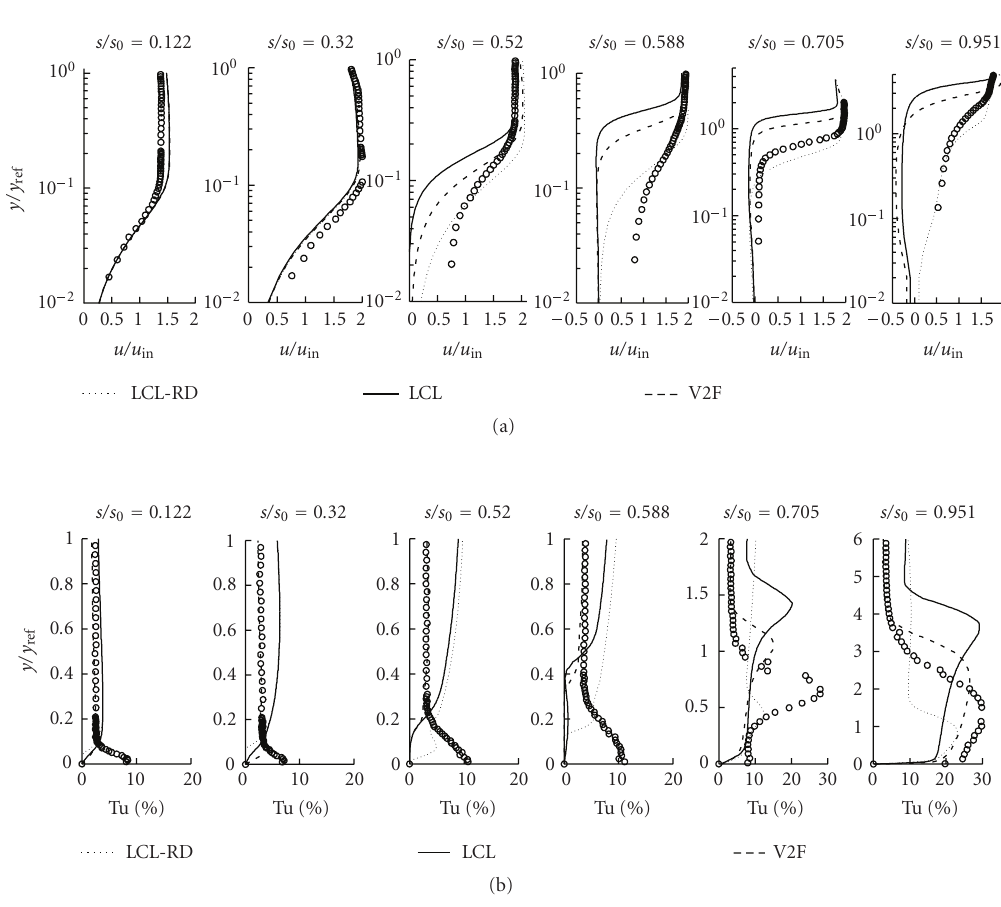
profile in and downstream of the separation is even qualita- tively